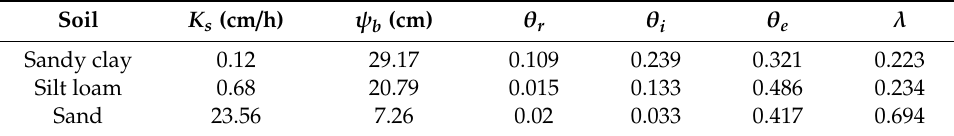
Table 2. Soil textures and parameters used in model evaluation.